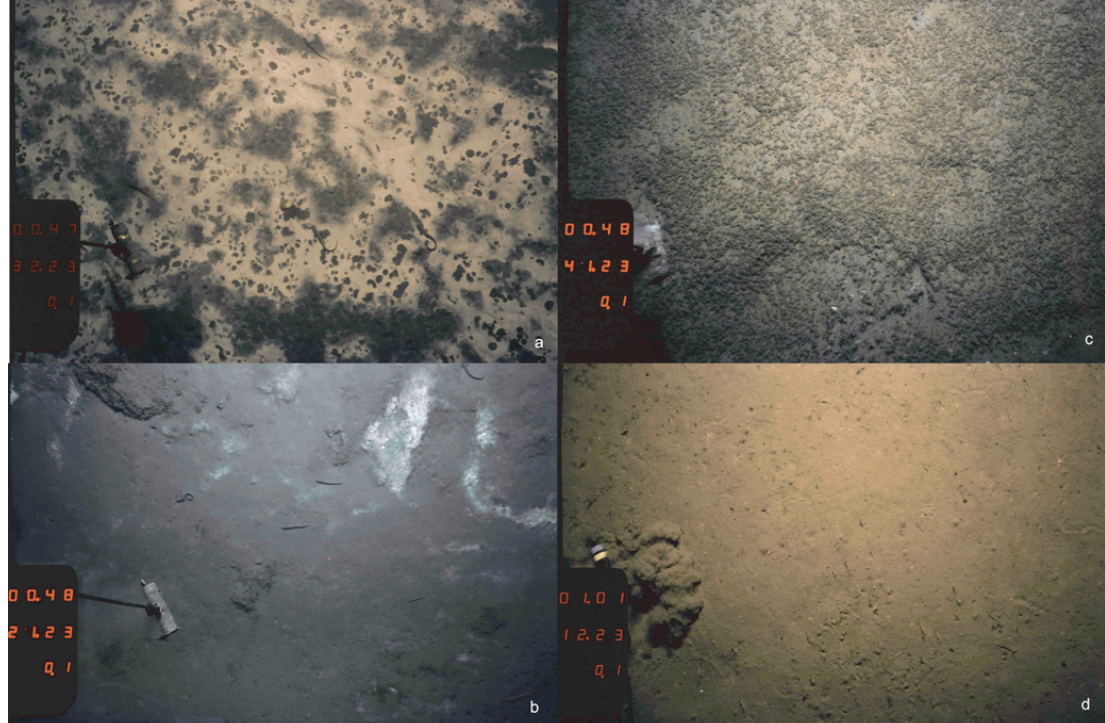
Fig. 7. Images from different habitats. (a) bacterial mat (coverage > 80%) with fish Lycodes squamiventer ; (b) patches of bacterial mat ( < 10%) on grey sediment, fish Lycodes squamiventer ; (c) tube worms Archeolinum contortum ( > 50%); (d) plain light-coloured sediments with numerous ophiuroids, Ophiocten gracilis